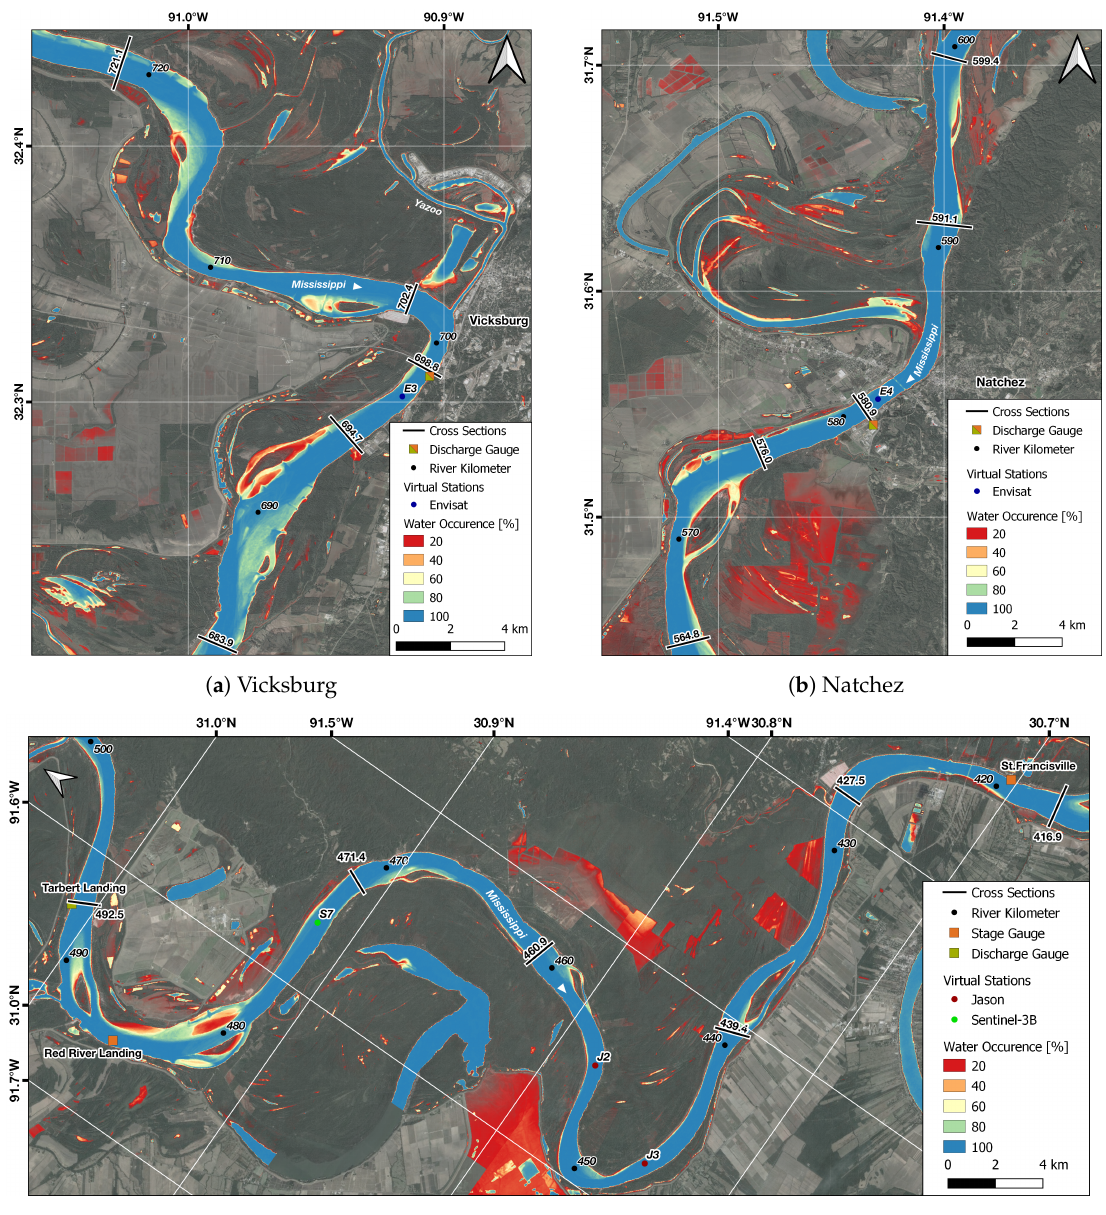
Figure 7. Water occurrence, gauges, virtual stations, and cross-sections within the study